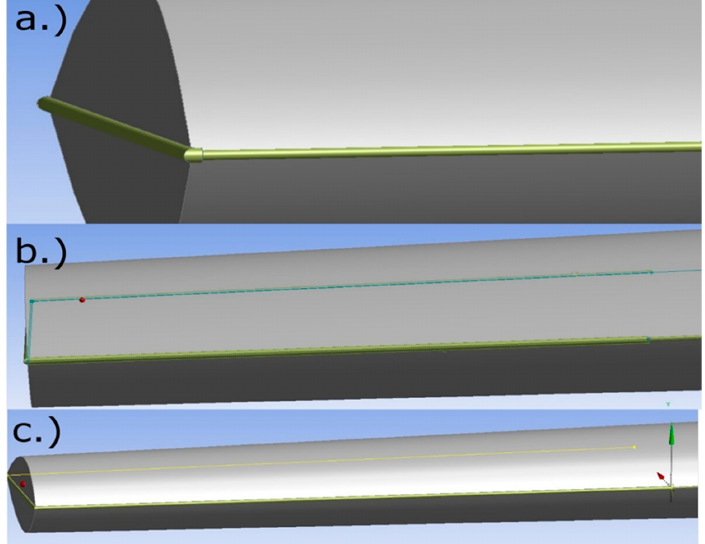
Figure 4. Hybrid conductor designs; ( a ) thicker conductor for tip, ( b ) thicker conductor for tip with 2 m on sides, ( c ) thicker conductor for tip with 5 m on